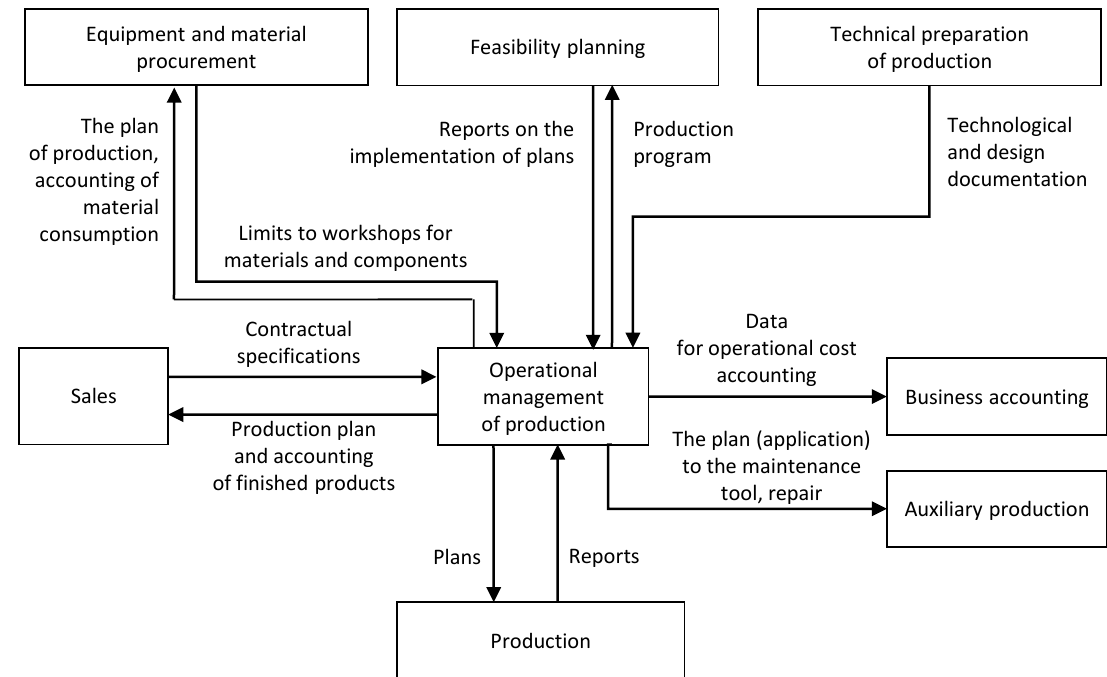
Figure 2. Information flows between the service of operating production